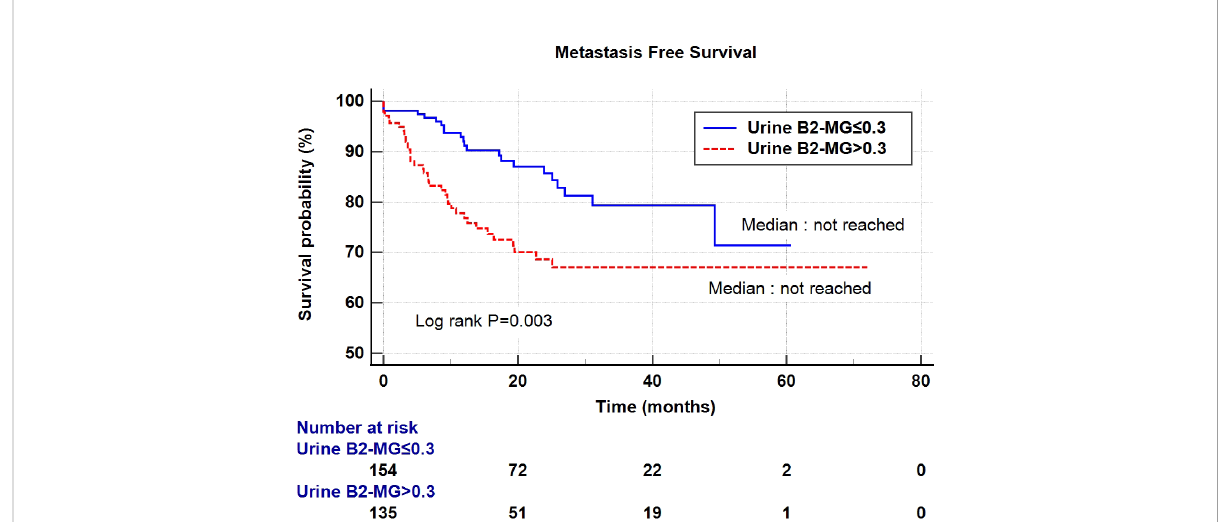
FIGURE 2 Kaplan-Meier curve of the effect of low urine B2-MG ( ≤ 0.3) (blue) and high urine B2-MG (> 0.3) (dotted red) groups on metastasis-free